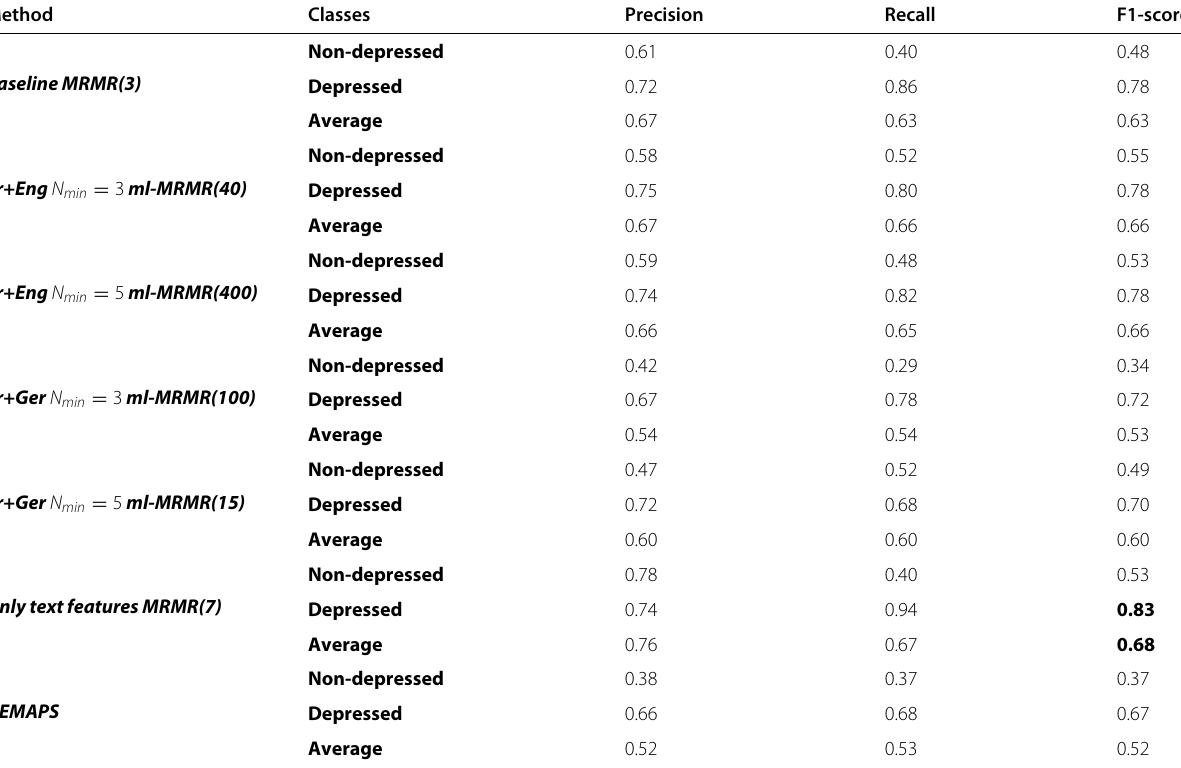
Table 5 Best classification results for Turkish Task. Avec 2013 feature set used for all results except Gemaps row. There are 50 depressed and 27 non-depressed subjects in the database. Number of selected features are shown in parenthesis for each case. Results are statistically insignificant except the classification using text-only features Method Classes Precision Recall F1-score Non-depressed BaselineMRMR(3)